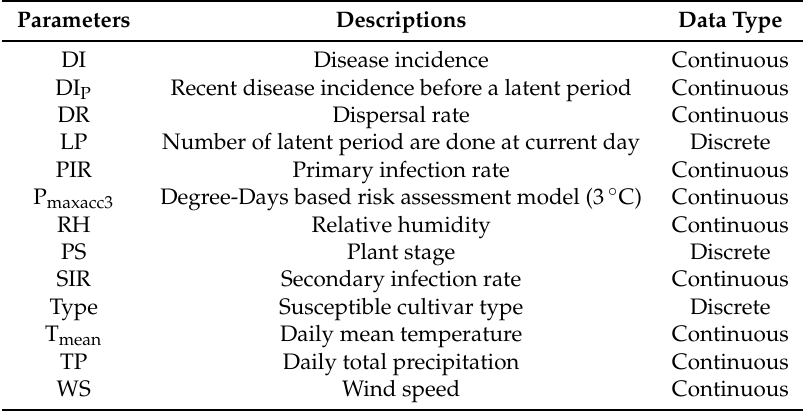
Table 2. Variables for structural learning by the Grape PM